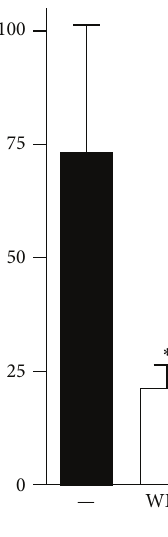
Figure 1: Efferocytosis involves PAFR and CD36. BMDM plated on coverslips were treated with PAFR antagonists WEB (WEB2086, 50 𝜇 M) or CV (CV3988, 10 𝜇 M) alone or in association with a specific blocking antibody to CD36 (1 𝜇 g/mL) for 30min before addition of apoptotic thymocytes (10 per macrophage). After 90 min of phagocytosis, cells were washed for removal of noningested targets and coverslips were stained with haematoxylin/eosin. The phagocytic indexes (derived by multiplying the percentage of macrophages containing at least one ingested target by the number of targets ingested by the macrophages) were assessed by cell counting under an optical microscope. Values are mean ± SEM of at least three independent experiments ( ∗ 𝑃 < 0.05 versus control; ∗∗ 𝑃 < 0.01 versus control; # 𝑃 < 0.05 versus WEB, CV, and CD36